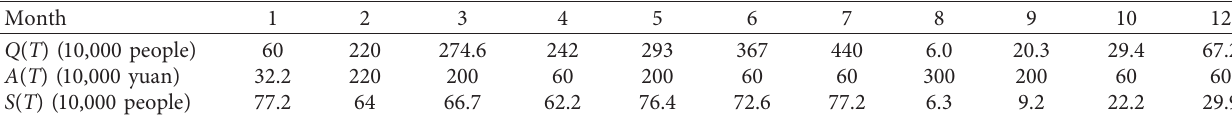
Table 3: Various parameter values estimated every month.